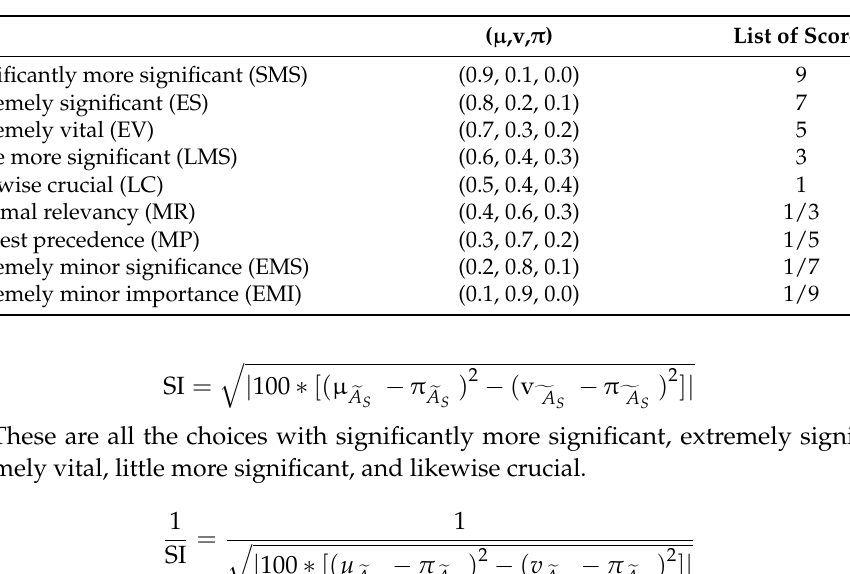
Table 2. Important lexicons in